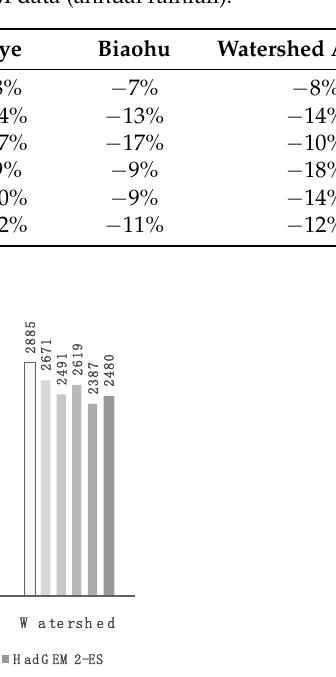
Table 4. Comparison between the station data and GCM data (annual rainfall).